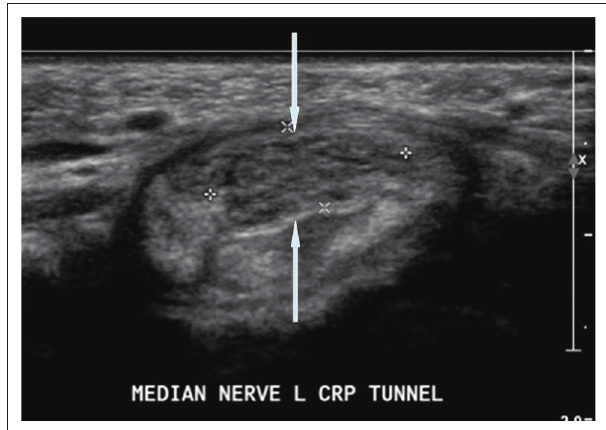
FIGURE 3: Transverse ultrasound image demonstrates enlargement of the median nerve with alternating hypoechoic and hyperechoic dots resulting in a ‘ coaxial cable-like’ appearance (white arrows).